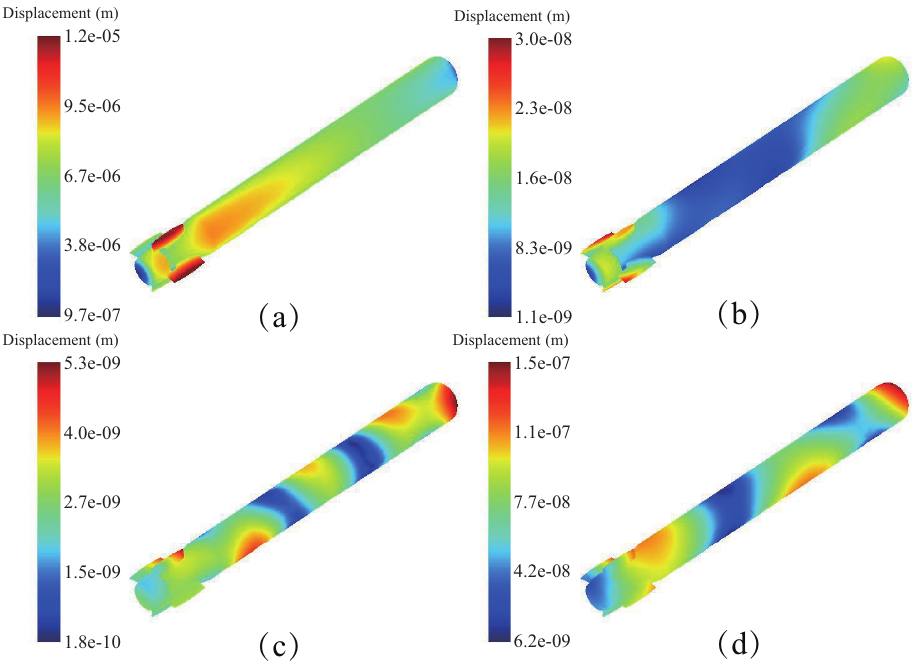
Figure 10. ( a – d ) Vibration displacement